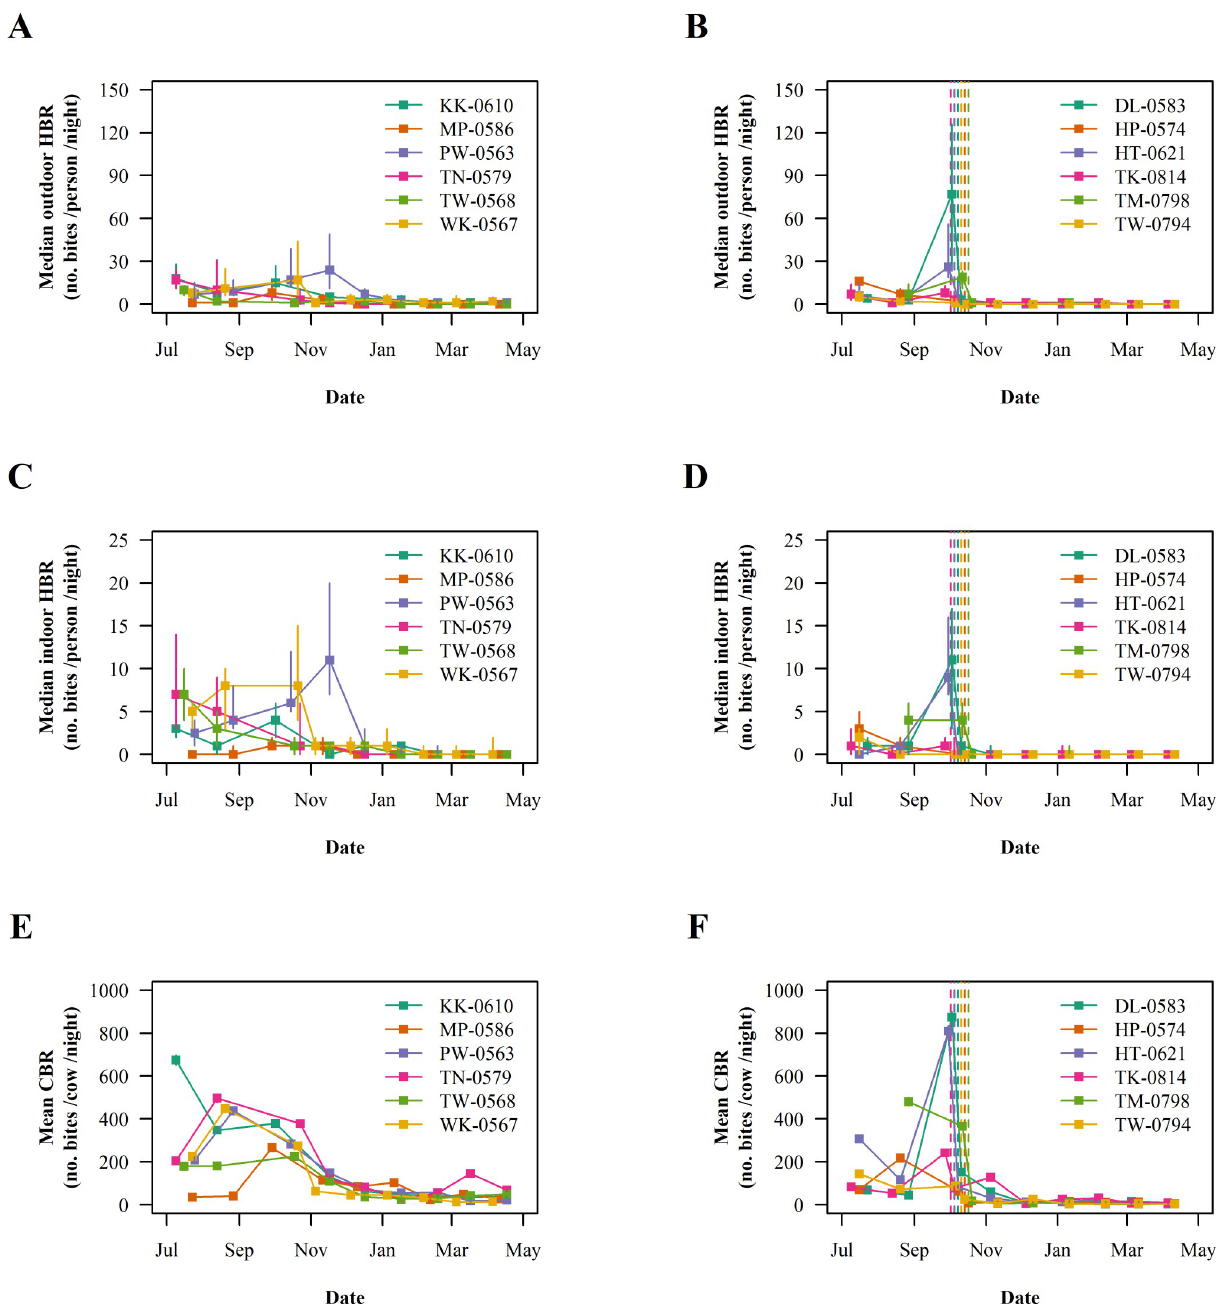
Fig 2. Evolution of the median biting rates of malaria mosquitoes during the follow-up. (A) Indoor human-biting rate in the control villages, (B) indoor human-biting rate in the sprayed villages, (C) outdoor human-biting rate in the control villages, (D) outdoor human-biting rate in the sprayed villages, (E) cow-biting rate in the control villages and (F) cow-biting rate in the sprayed villages. Vertical solid bars show the interquartile range. Vertical dashed lines show intervention dates. intervals were broad because the number of cases and clusters were small. Consistent with the